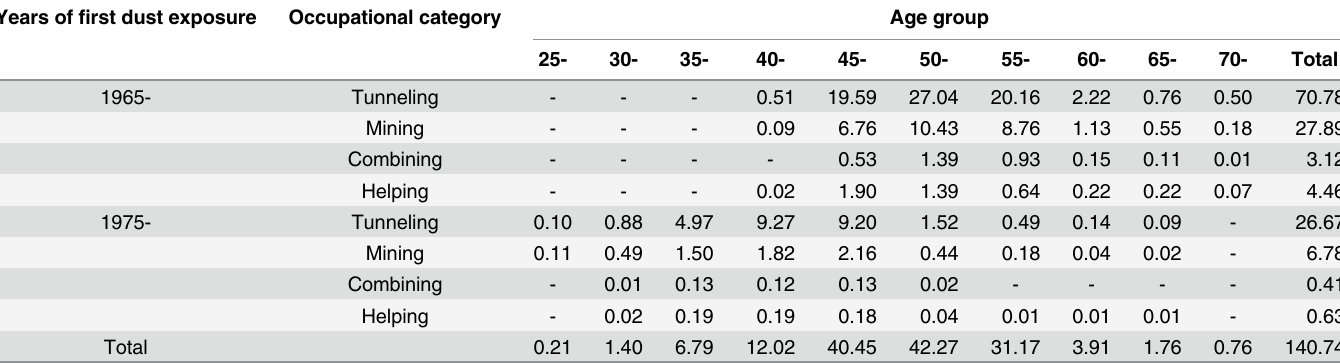
Table 2. Possible CWP cases among redeployed coal workers by age group as of 2012.